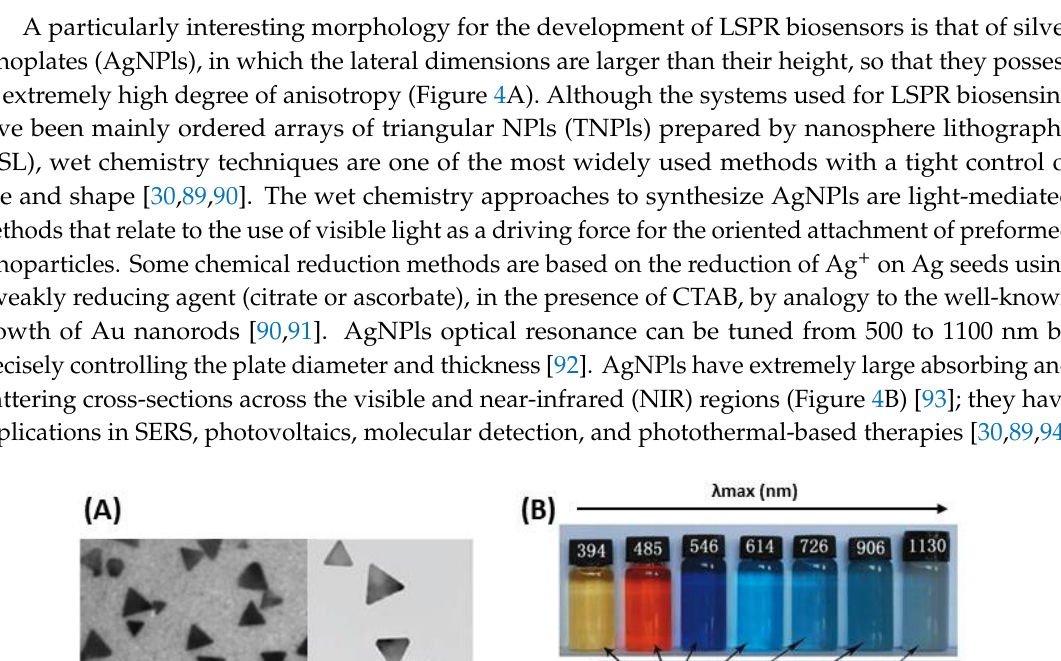
Figure 3. TEM images of silver nanoparticles with different shapes: ( A ) nanospheres, ( B ) nanoprisms, ( C ) nanobars and ( D ) nanowires. SEM images of ( E ) nanocubes, ( F ) pyramids, ( G ) nanorice and ( H ) nanoflowers. Adapted from [54,56]. Copyright (2009), Springer Science Business Media, LLC.